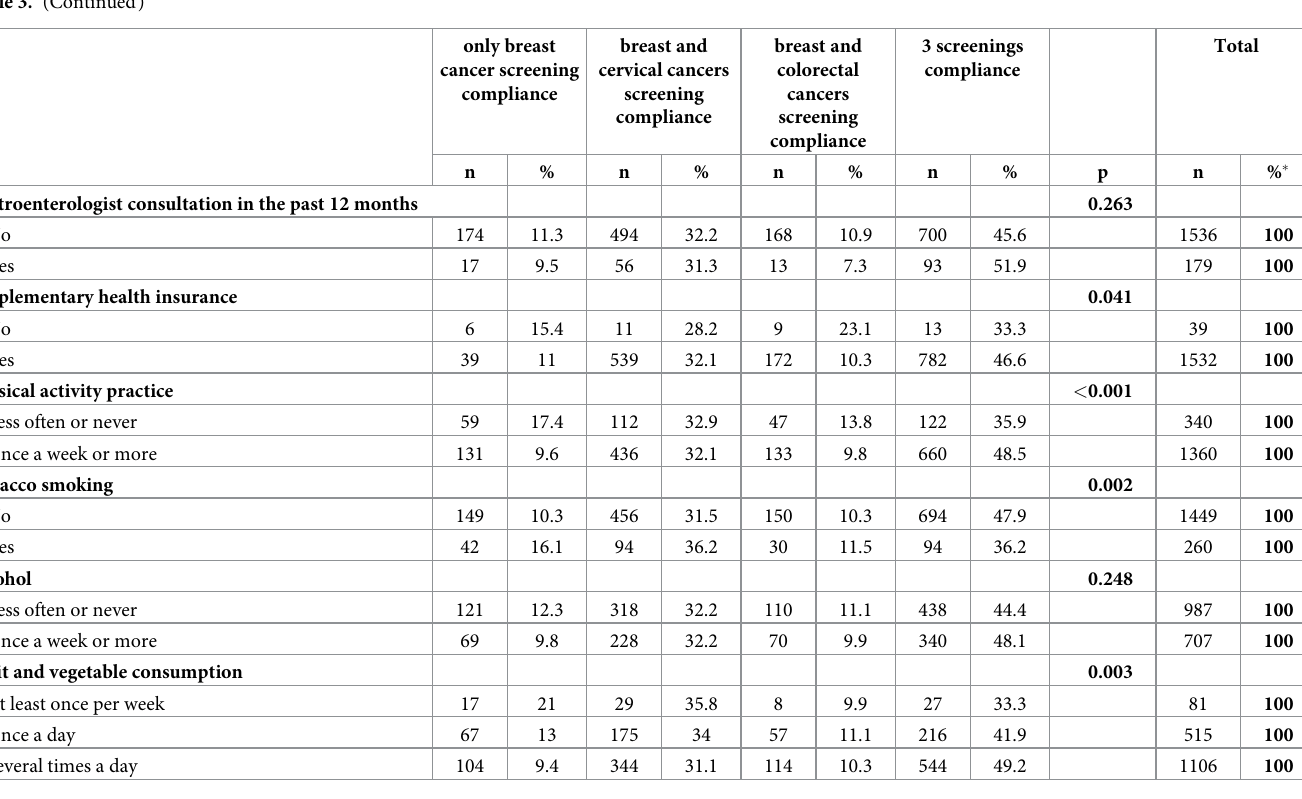
than 59 and those who got a yearly flu vaccine were less likely to participate in gynecological cancer screenings only (OR = 0.57, p < 0.001 and OR = 0.68, p = 0.008, respectively). On the contrary, senior managers, self-employed, traders and women with a family history of colorectal cancer were more likely to attend only female cancer screenings, compared to all 3 screenings (OR = 1.65, p = 0.009 and OR = 1.48, p = 0.013, respectively). This reflects a lower involvement in organized colorectal cancer screening.